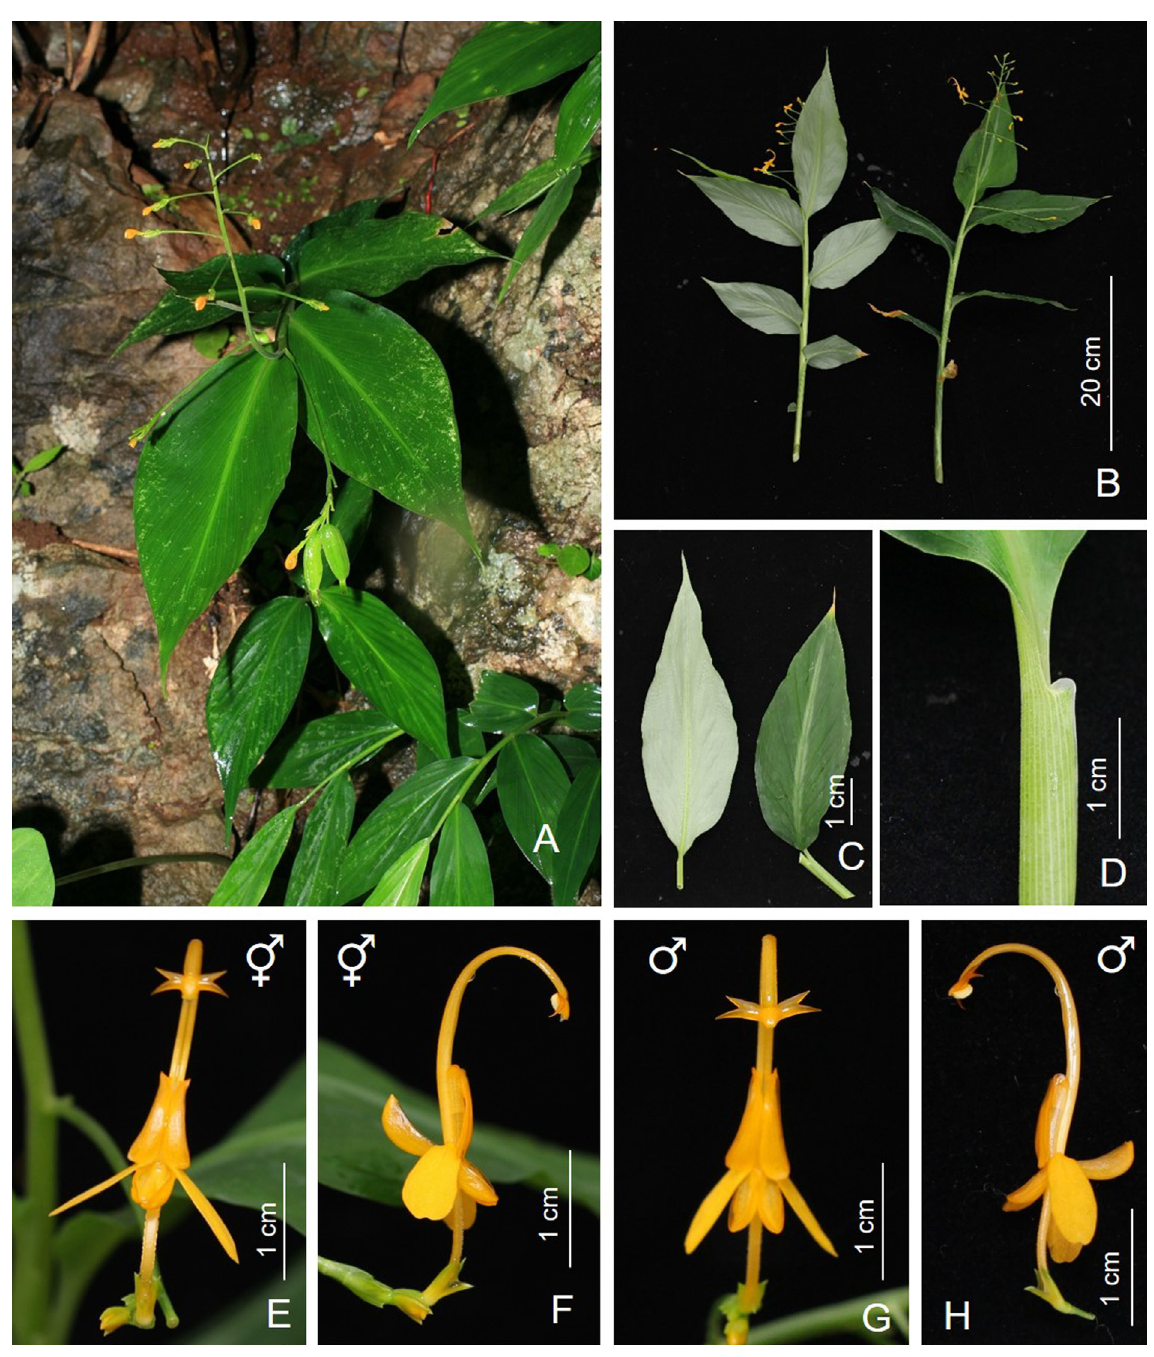
Fig. 12. Globba lithophila Sangvir. & M.F.Newman sp. nov. A . Plant in its habitat. B . Habit. C . Leaves. D . Ligule. E . c flower (front view). F . c flower (side view). G . ♂ flower (front view). H . ♂ flower (side view). Photographs: S. Sangvirotjanapat from S. Sangvirotjanapat 642